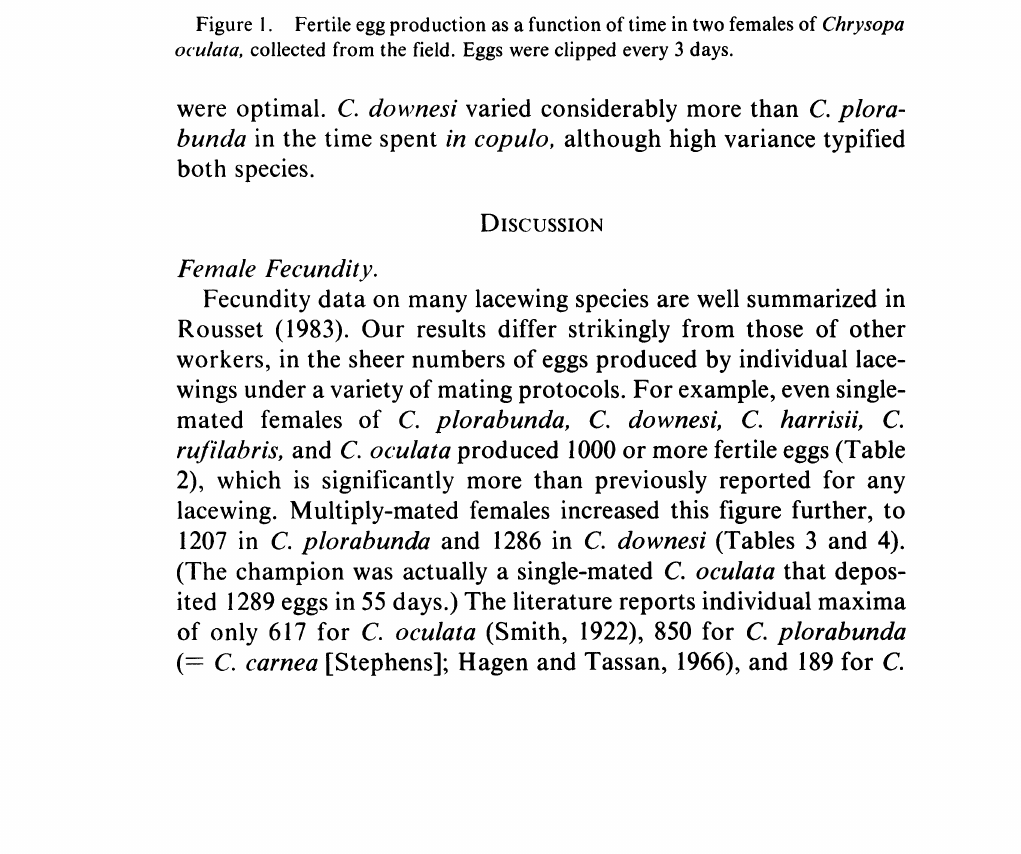
Figure I. Fertile egg production as a function of time in two females of Chrysopa oculata, collected from the field. Eggs were clipped every 3 days. were optimal. C. downesi varied considerably more than C.